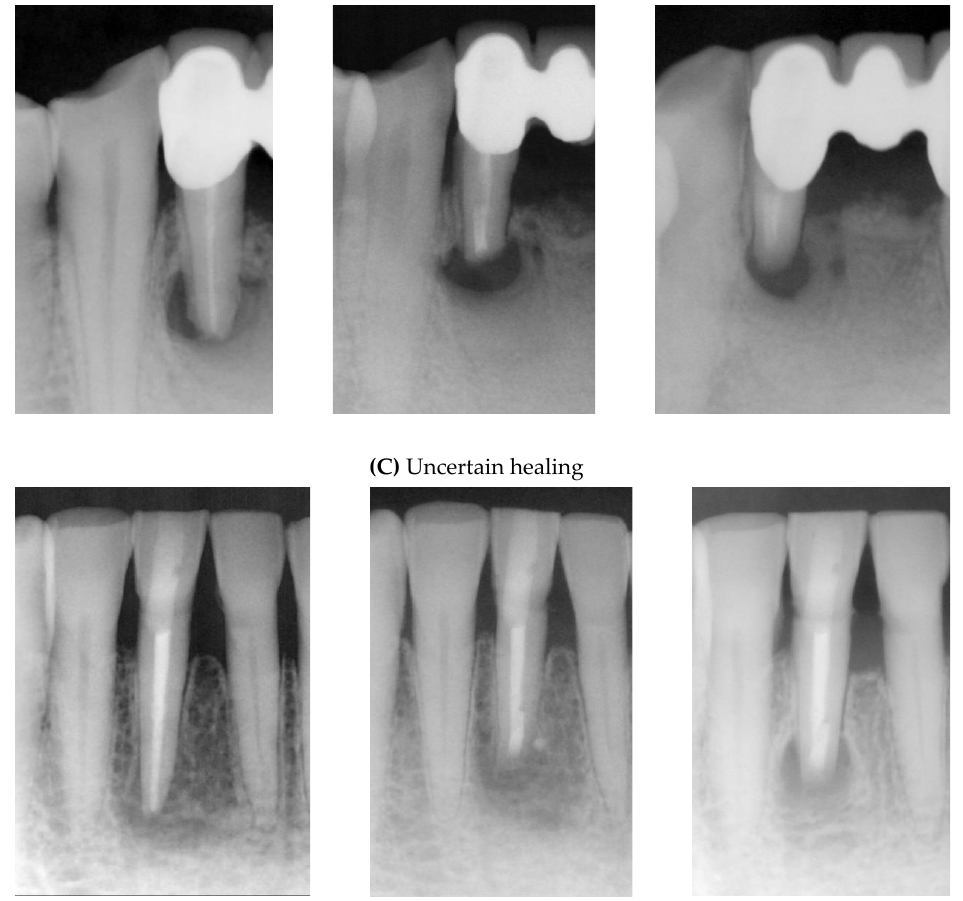
Figure 1. Periapical radiographs demonstrating healing outcomes. ( A ) Complete healing; preoperative (left), postoperative (center), and 14-year follow-up (right) radiographs showing complete healing of #15 and #16. ( B ) Incomplete healing; preoperative (left), postoperative (center), and 14-year follow-up (right) radiographs showing incomplete healing (scar tissue) of #12. ( C ) Uncertain healing; preoperative (left), postoperative (center), and 8-year follow-up (right) radiographs showing uncertain healing of #42. ( D ) Unsatisfactory healing; preoperative (left), postoperative (center), and 4-year follow-up (right) radiographs showing unsatisfactory healing of #41.